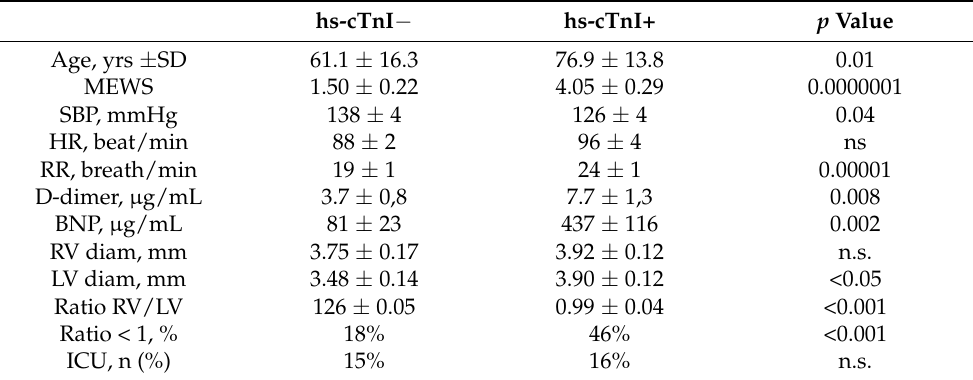
Table 4. Patient’s parameters and laboratory test differences between the two groups: with a value of troponin within a normal range (hs-cTnI − ) and those with a troponin level above the upper range (hs-cTnI+) in the prospective